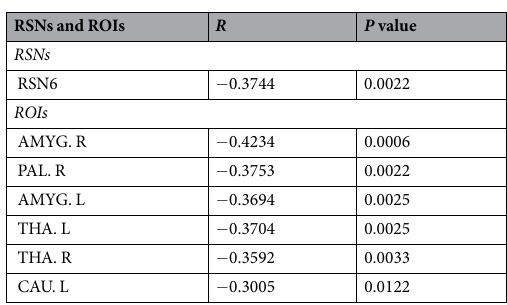
Table 2. Associations between age and SampEn of RSNs and ROIs in healthy subjects. R is the partial correlation coefficient. RSN 6, the subcortical network; AMYG, amygdala; PAL, pallidum; THA, thalamus; CAU, caudate; L, left; R, right.